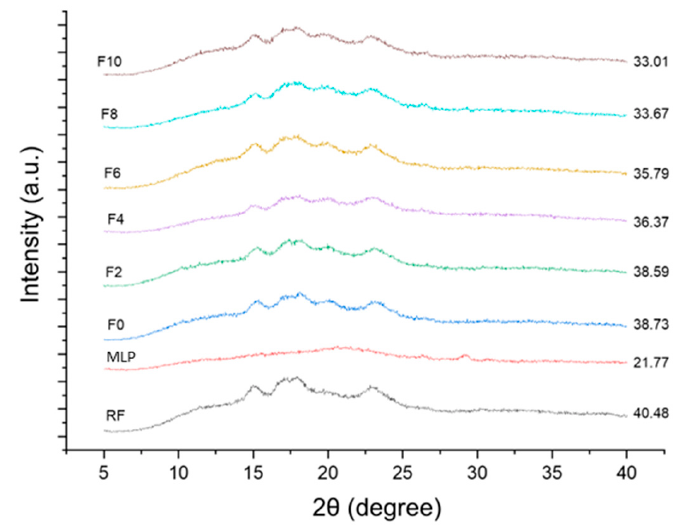
Figure 8. X-ray diffraction pattern of RF, MLP, F0, and FRN samples. RF represents rice flour, MLP represents marjoram leaf powder, F0 represents 0% MLP, F2 represents 2% MLP, F4 represents 4% MLP, F6 represents 6% MLP, F8 represents 8% MLP, and F10 represents 10% MLP.